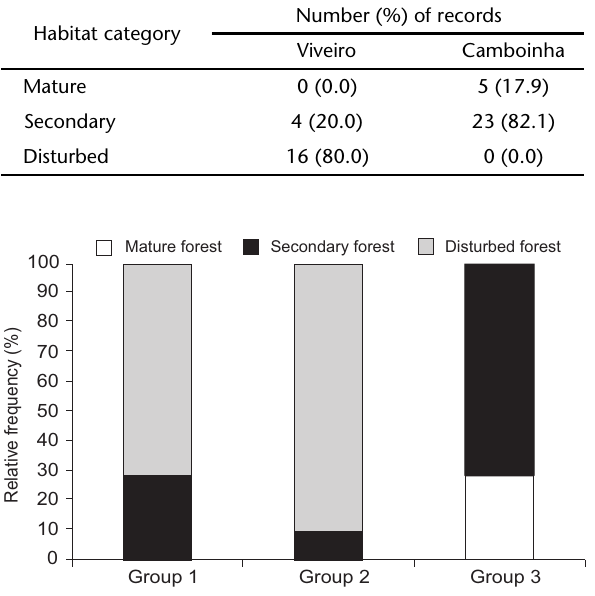
Figure 1. Relative frequency of encounters with the three C. coimbrai study groups at the Fazenda Trapsa by habitat category.